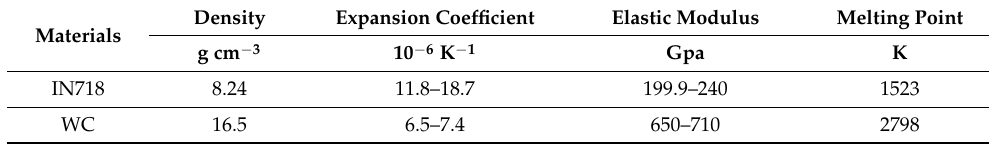
Figure 4. Cross-sectional morphologies of different coatings: ( a ) Coating A; ( b ) Coating B; ( c ) Coating C; 1 and 2 represent partial enlarged images of the top and bottom regions respectively. Table 3. Physical properties of bonding metal IN718 alloy and WC